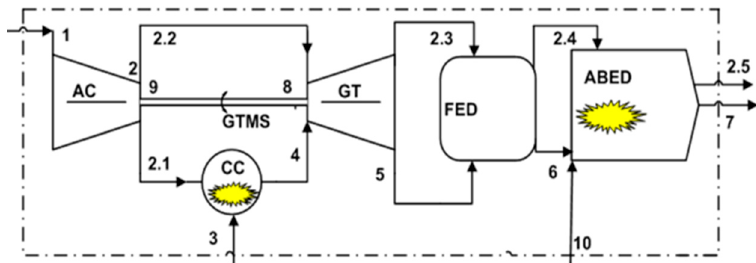
Figure 1. A simply view and flow diagram of the turbojet engine (TJE) [63].